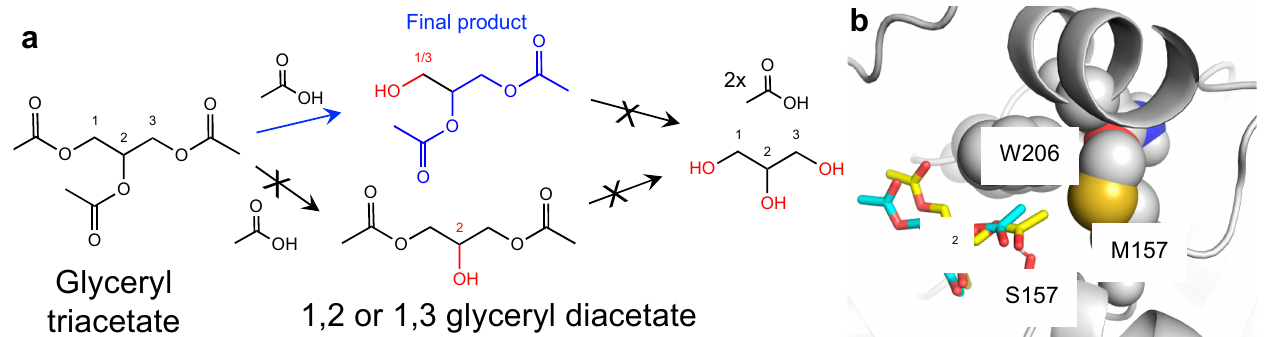
Figure 2. Triacetin as a substrate. ( a ) Potential routes of triacetin hydrolysis. The final observed product is shown in blue (1,2-glyceryl diacetate) with other potential products (1,3-glyceryl diacetate, the monoacetates or glycerol) not observed coloured black. ( b ) Triacetin docking to EstN7. Two docked forms of triacetin (yellow and cyan) are shown. The cluster represented the lowest HADDOCK score ( − 24.0 ± 0.6) observed for the simulation. The central C2 carbon of the glycerol backbone is highlighted for reference.